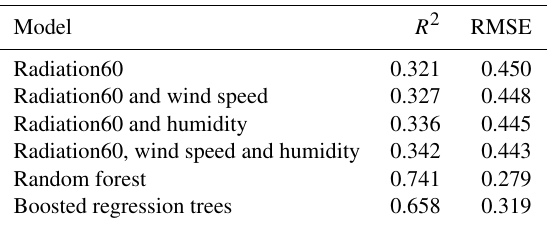
Table 8. The coefficient of determination ( R 2 ) and root-mean- square error (RMSE) of the different